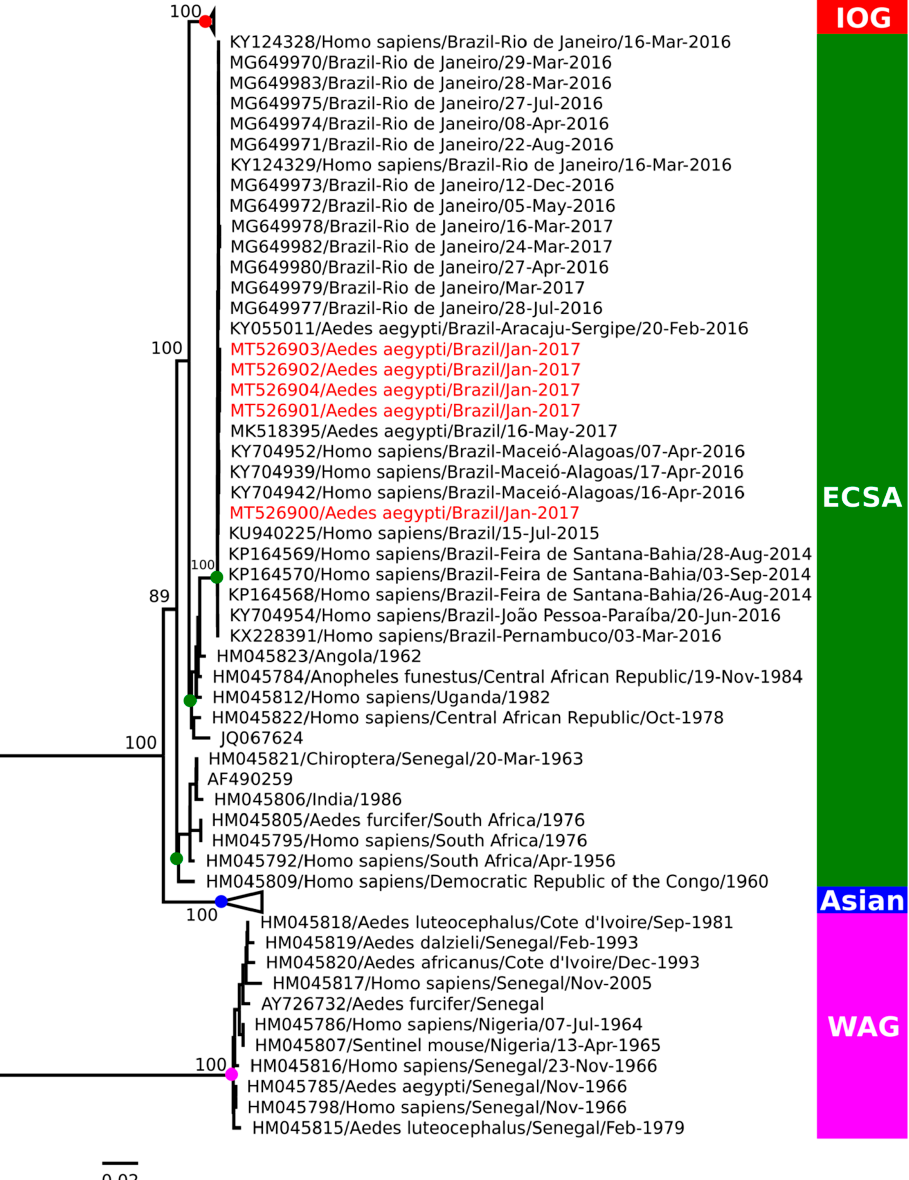
Figure 2. Maximum likelihood phylogenetic analysis based on the complete genome of chikungunya virus (CHIKV) isolated in females of Ae. aegypti and Cx. quinquefasciatus , collected during an outbreak in the Amazon region in 2017. The strains sequenced in this study are in red. Colored circles—red, green, blue and magenta—on the tree nodes represent the Indian Ocean, ECSA, Asian and West Africa clusters, respectively.